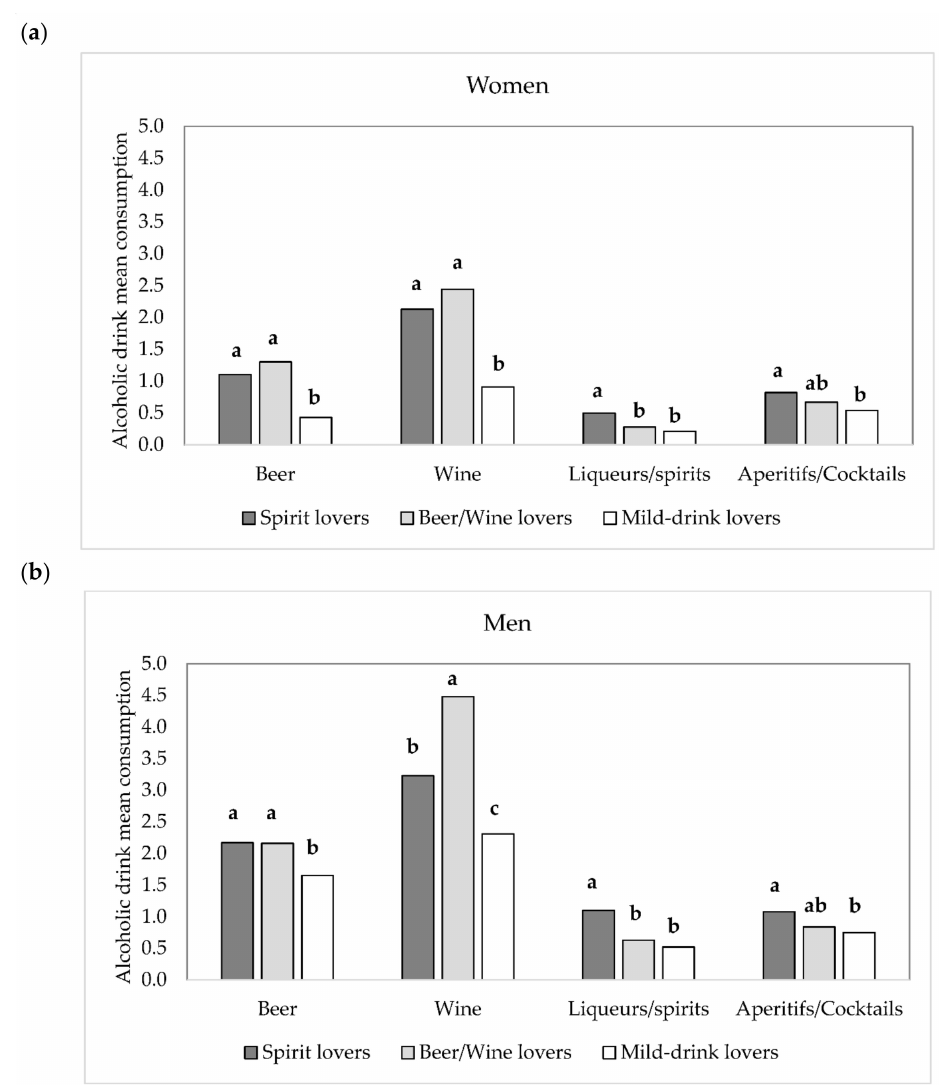
Figure 3. Alcoholic beverage mean consumption for the three consumers segments (spirit lovers, beer / wine lovers, and mild-drink lovers) of women, n = 1353 ( a ) and men, n = 978 ( b ). Di ff erentlettersindicatesignificantdi ff erencesaccordingtoBonferronipost-hoctest. Meanconsumption: Beer = cans / glasses per week, wine = glasses per week, spirits = times per week, alcoholic beverages = times per